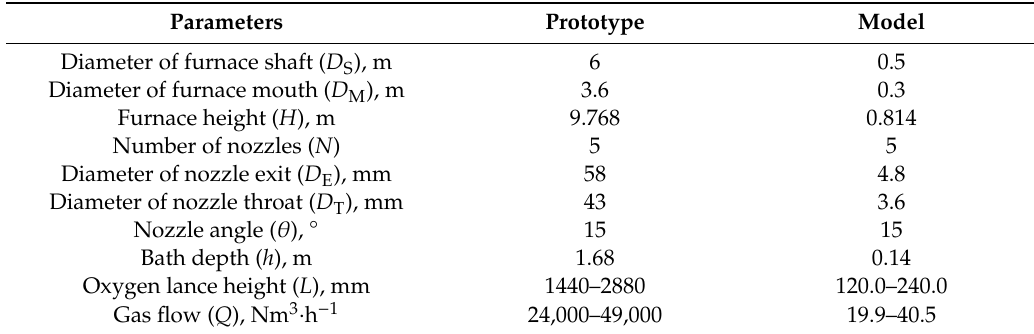
Table 2. Parameters of prototype versus model.